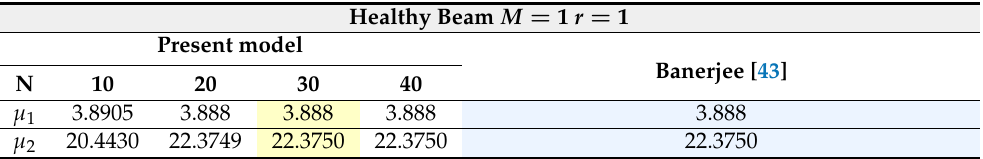
Table 2. Comparison between the present model results and results from Banerjee [43]. Reprinted/adapted with permission from [43]. 2000,